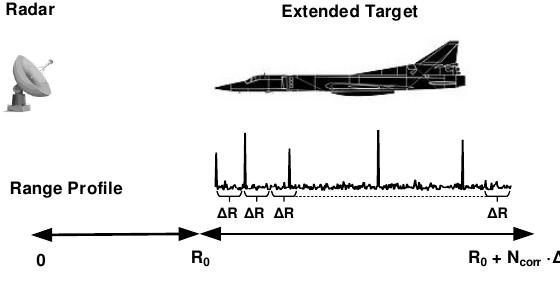
Figure 1. Illustration of the overall radar system